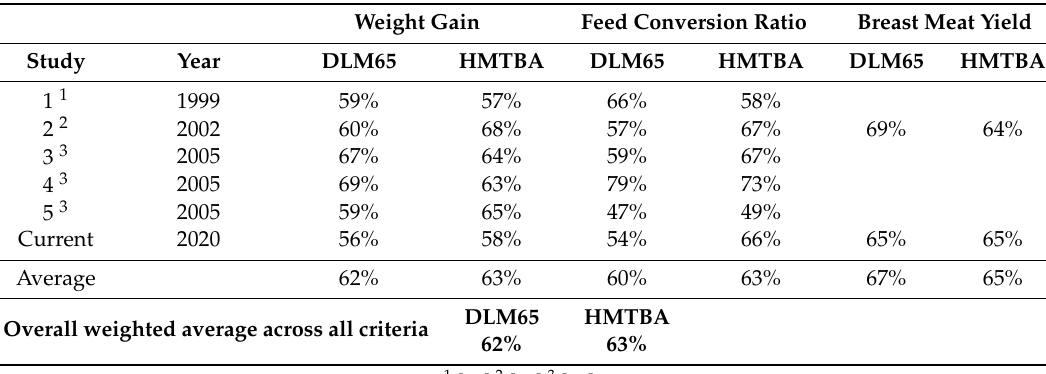
Table 6. Compilation of the literature findings and results of the current study on relative bioavailability value (RBV) of DL-2-hydroxy-4-methylthio butanoic acid (HMTBA) and to 65% purity diluted DLM (DLM65) compared to DL-Methionine (DLM). Weight Gain Feed Conversion Ratio Breast Meat Yield